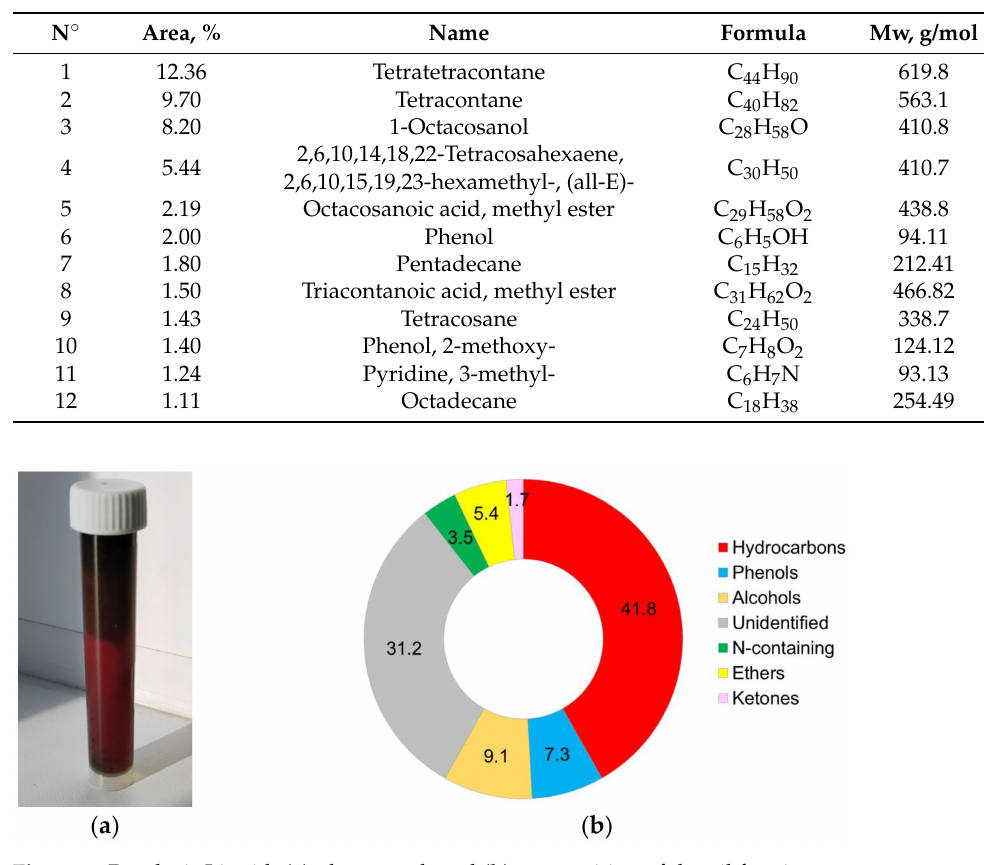
Figure 2. Pyrolysis Liquid: ( a ) photograph and ( b ) composition of the oil